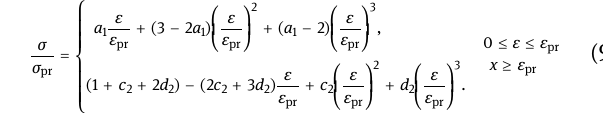
Figure 11: The in fl uence of a 1 on the ascending segment curve.